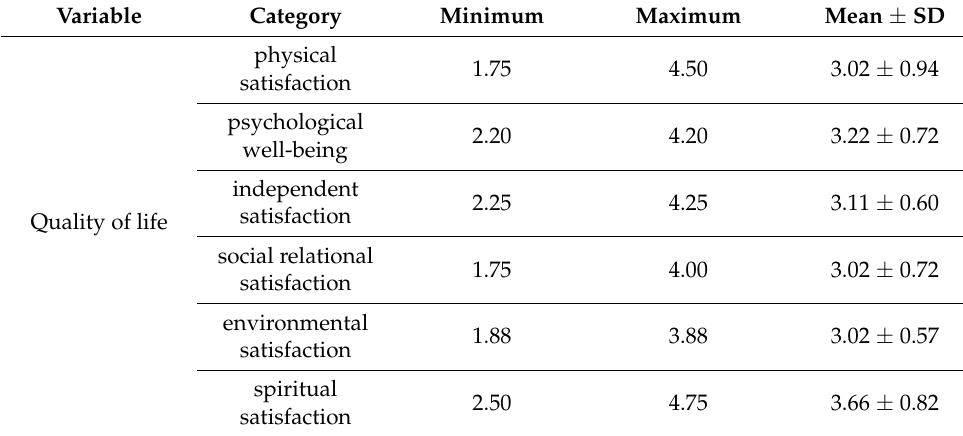
Table 3. Descriptive statistical analysis of quality of